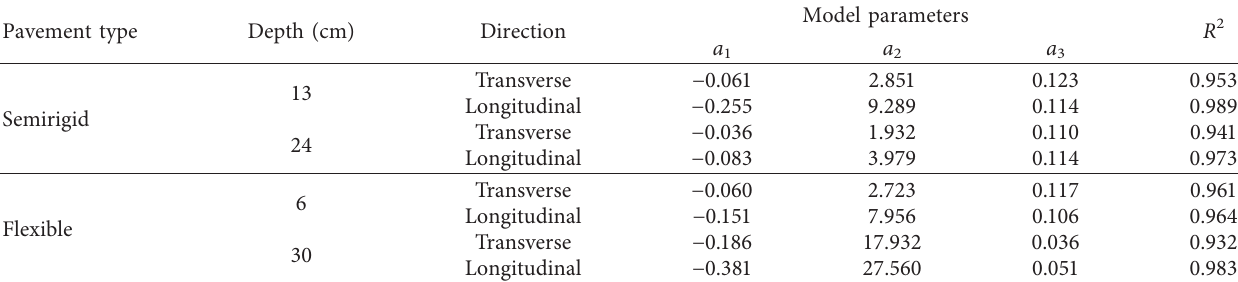
Table 5: The fitting results of equation (1) for different types of strain